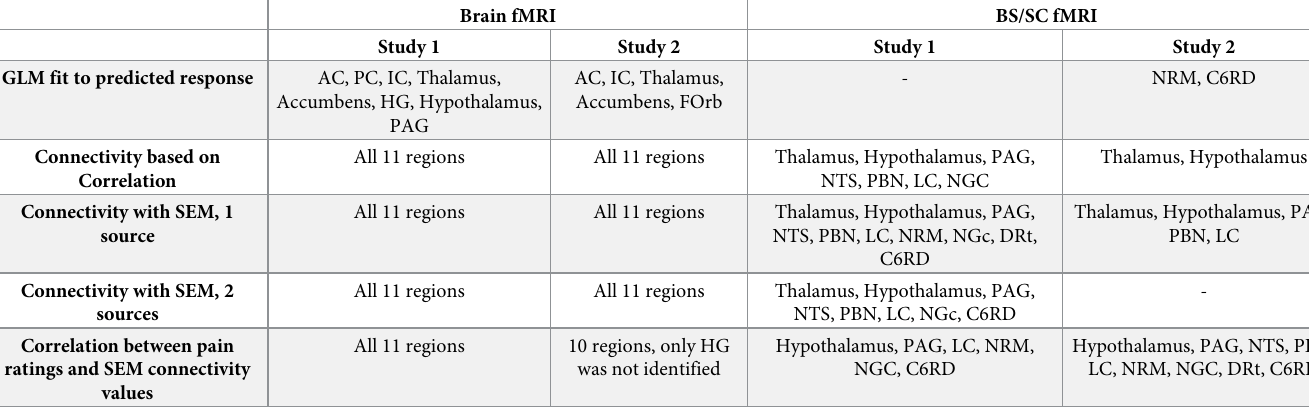
Table 2. Summary of the regions identified with each of the analysis